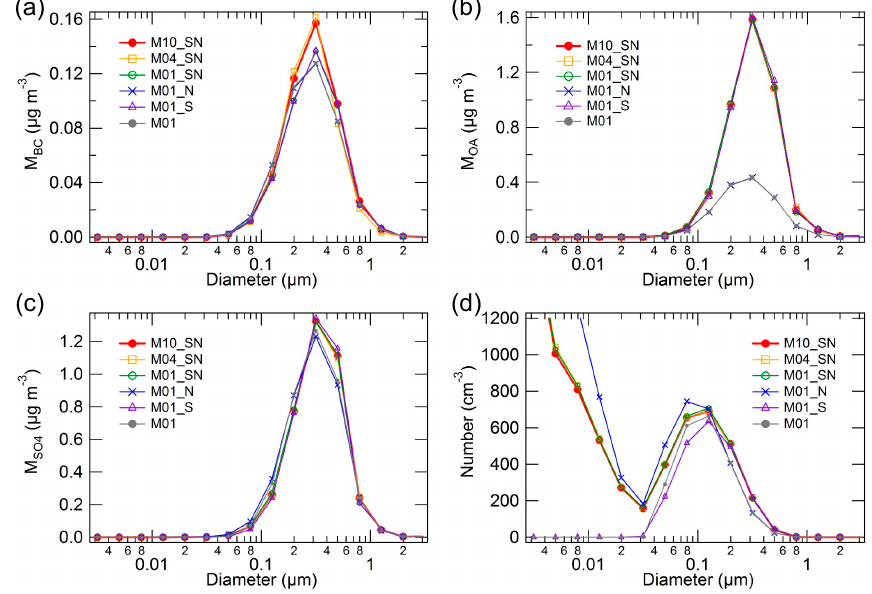
Figure 6. The period- and domain-averaged size distributions of (a) BC, (b) OA, and (c) sulfate mass concentrations and (d) number concentrations at a sigma level of 0.895 ( ∼ 1km) in six simulations (the simulations are defined in Table